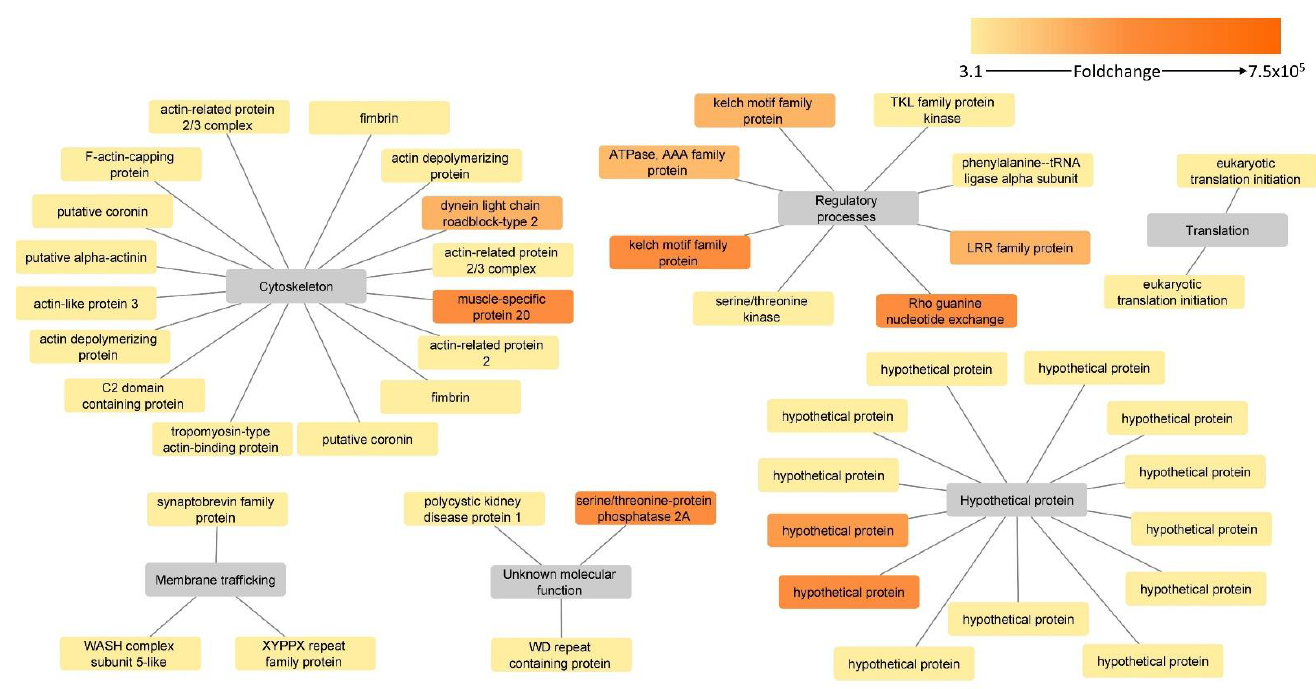
Figure 7. Putative surface-associated, upregulated proteins in the attenuated strain of H. meleagridis . Protein-function network graphs of H. meleagridis proteins with significant upregulation in the attenuated strain (>2 fold change and p < 0.05). The protein identifications are represented by color- coded source nodes and connected with their proposed functions, represented by the target nodes. The source nodes are color-coded based on each protein fold change